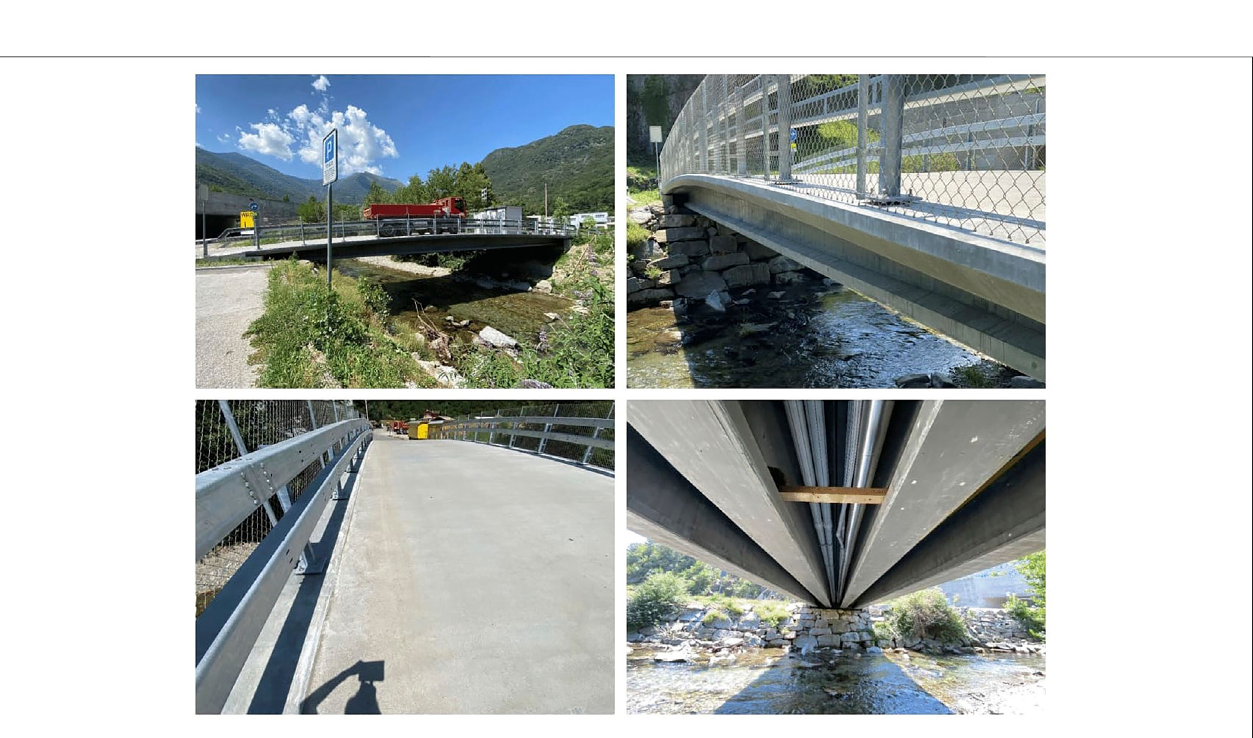
FIGURE 14 | Taverne bridge. (Photographs: E.